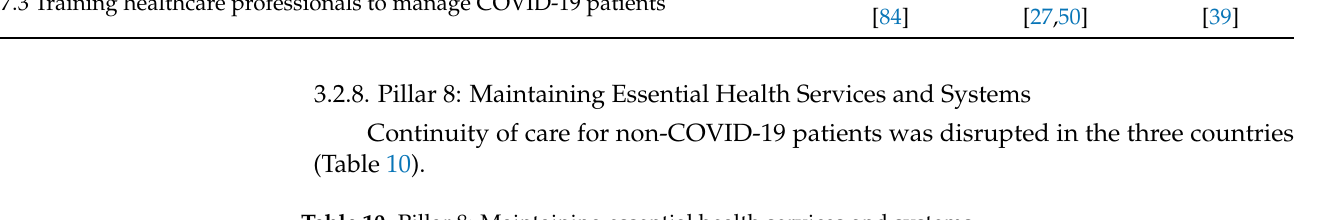
Table 10. Pillar 8: Maintaining essential health services and